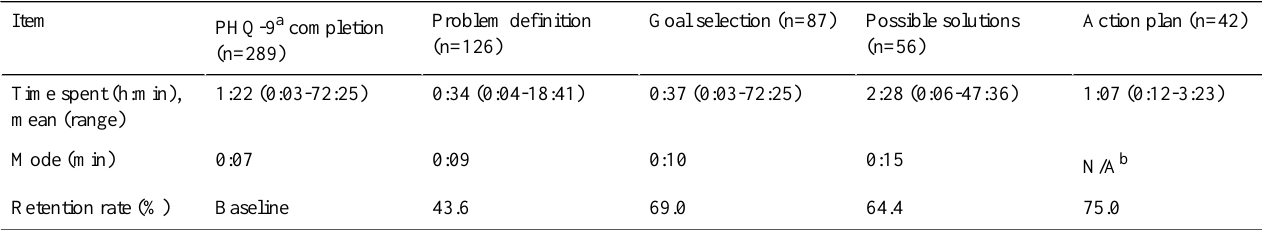
Table 2. Mood session one duration and attrition